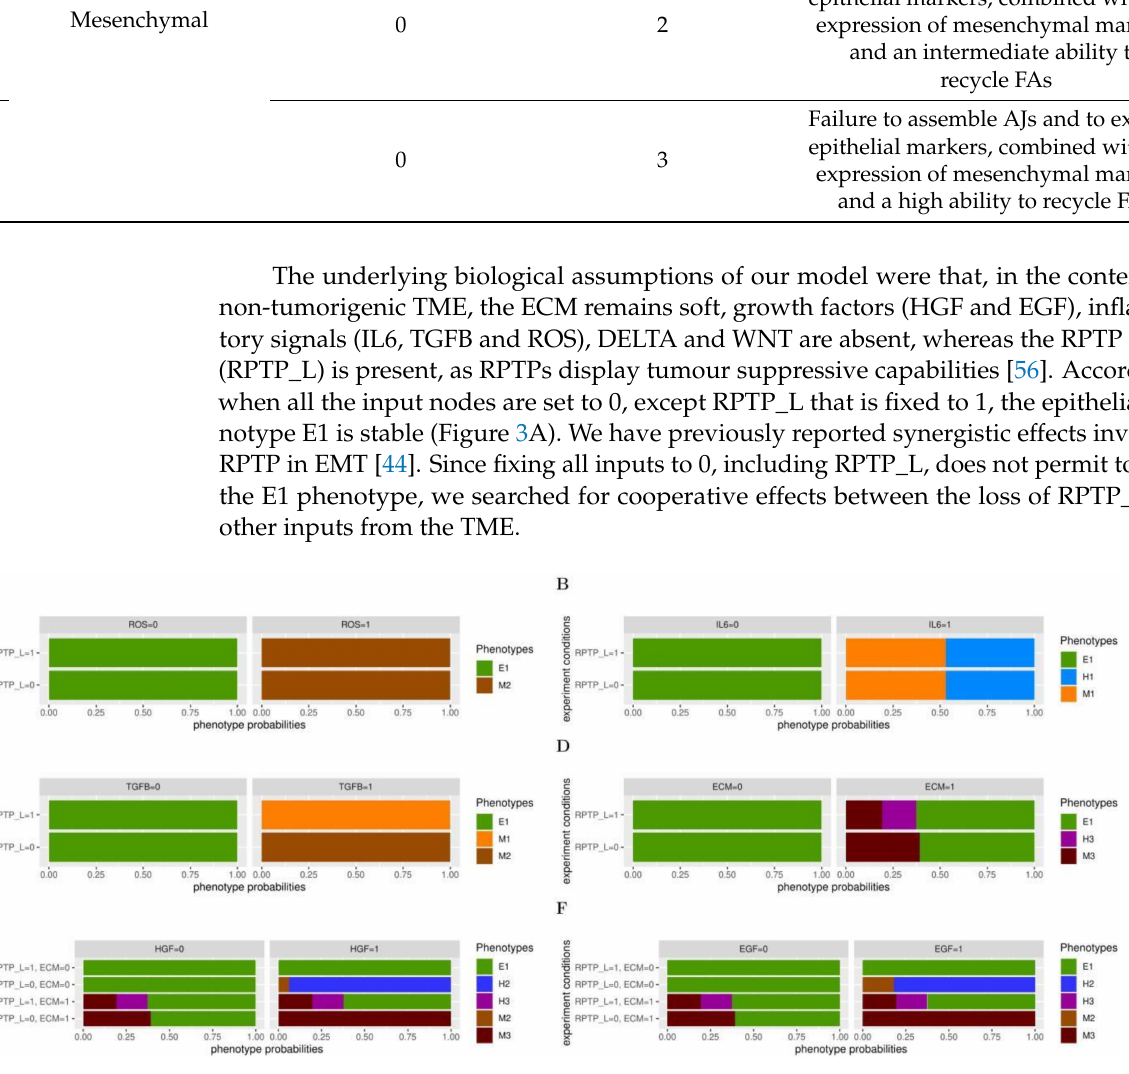
Figure 3. The EMT logical model predicts cooperation between RPTP_L and other microenvironment signals. Probabilities of the reachable phenotypes starting from an E1 phenotype, when switching single or multiple microenvironmental signals. ( A – D ) ROS ( A ) or IL6 ( B ) or TGFB ( C ) or ECM ( D ) is set up to 0 or 1, in the presence (=1) or absence (=0) of RPTP_L. ( E , F ) HGF ( E ) or EGF ( F ) is set up to 0 or 1, in the presence (=1) or absence (=0) of RPTP_L and of a stiff ECM. In each condition, inputs that are not indicated are fixed to